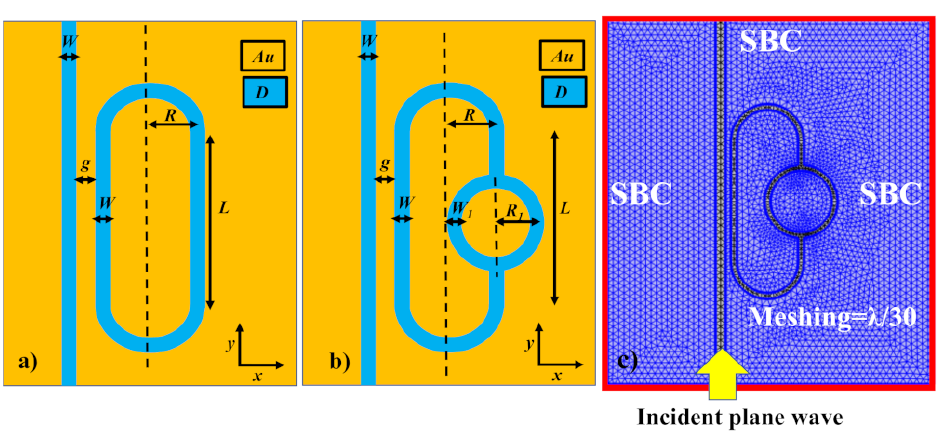
Figure 1. Graphical representation of the MIM WG plasmonic sensor: ( a ) SRTC, ( b ) RTICC, ( c ) meshing of the device